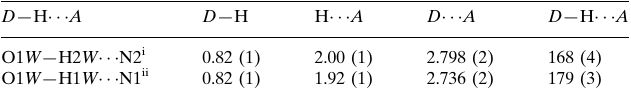
Hydrogen-bond geometry (A˚ , (cid:2)